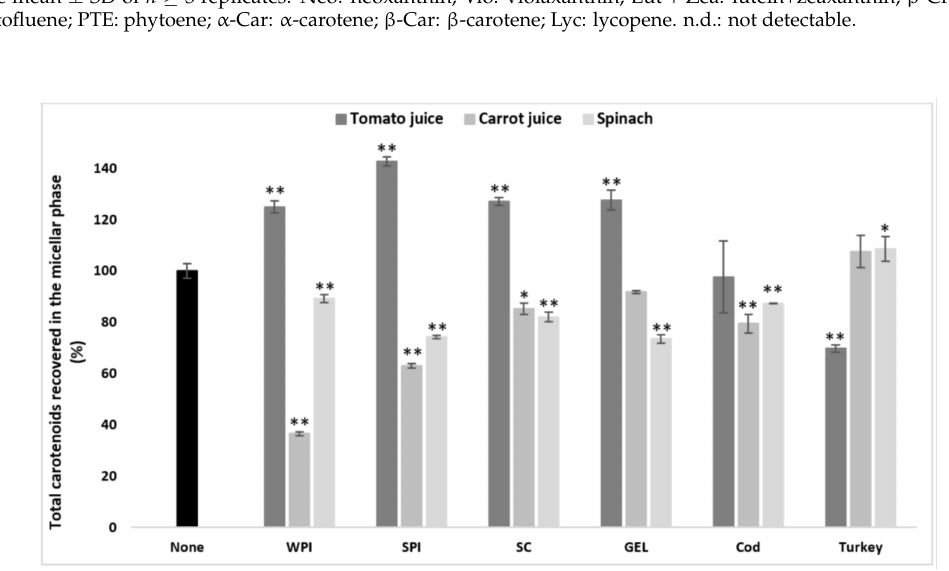
Figure 1. Influence of different proteins on the bioaccessibility of total carotenoids following sim- ulated GI digestions of tomato juice, spinach and carrot juice. Carotenoid rich-food matrices were digested in the absence or presence of different protein rich food items/supplements (cod, turkey, WPI, SPI, SC, and GEL) at a concentration of 50% of protein recommended dietary allowance (RDA, approx. 60 g/d for human adults [35]). Bioaccessibility is expressed as the percentage of carotenoids recovered from the aqueous micellar fraction at the end of the GI digestion, compared to the amount present in each matrix at the beginning of digestion. Bars represent means ± SD of n ≥ 4 and N ≥ 2 (sets repeated at different days). Columns labelled with either * ( p < 0.05) or ** ( p < 0.001) were significantly different from the control condition (no added